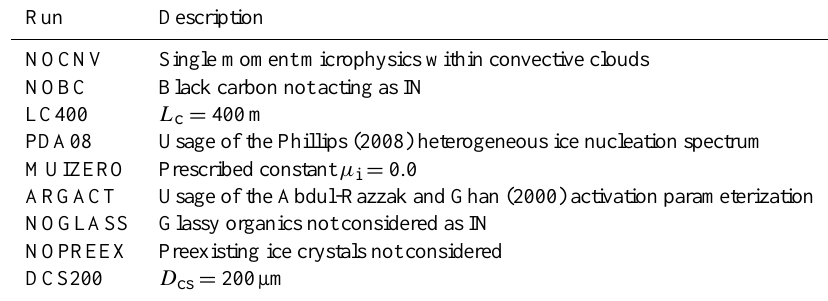
Table 3. Description of sensitivity runs performed with GEOS-5 using the new microphysics. Run Description NOCNV Single moment microphysics within convective clouds NOBC Black carbon not acting as IN LC400 L c = 400m PDA08 Usage of the Phillips (2008) heterogeneous ice nucleation spectrum MUIZERO Prescribed constant µ i = 0 . 0 ARGACT Usage of the Abdul-Razzak and Ghan (2000) activation parameterization NOGLASS Glassy organics not considered as IN NOPREEX Preexisting ice crystals not considered DCS200 D cs =